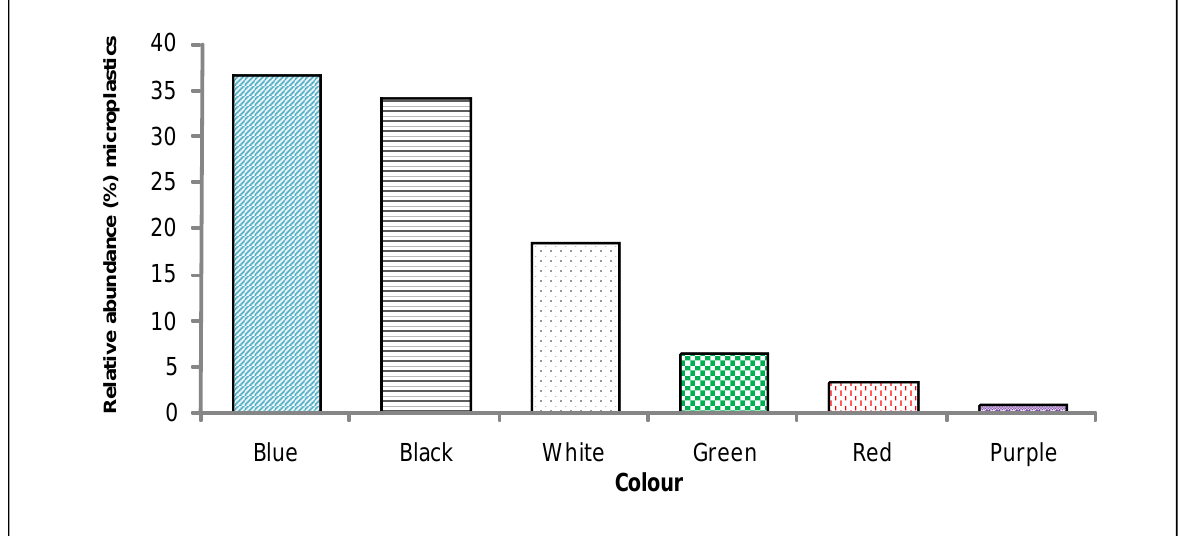
Figure 7: Mean percentage concentration of microplastic colors observed in different fish species from the creeks along the Kenya